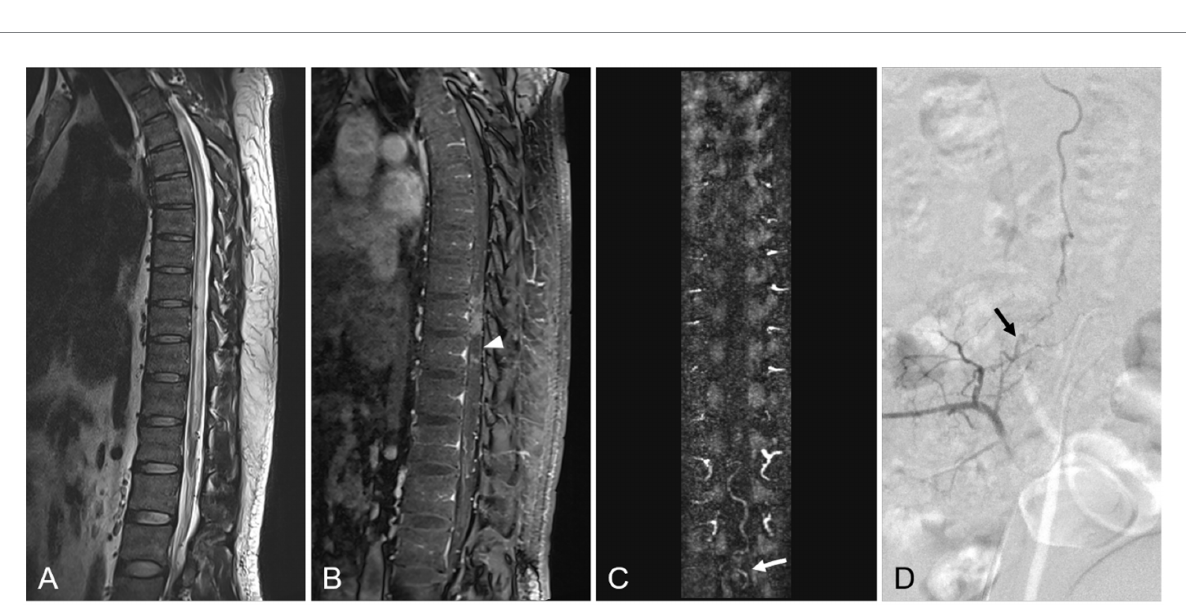
FIGURE 2 A 70-year-old patient with sacral SDAVF. (A) Sagittal T2-weighted image reveals a signal intensity increase of spinal cord, involving the conus. (B) The enhanced T1-weighted image demonstrates the patch unenhanced region in the spinal cord ( white arrowhead ). (C) In the coronal MRA MIP image, the dilated filum terminale vein suggests that the feeding artery is probably located in the sacrum ( white arrow ). (D) DSA examinations confirm that the fistula supplied via the right internal iliac artery ( black arrow